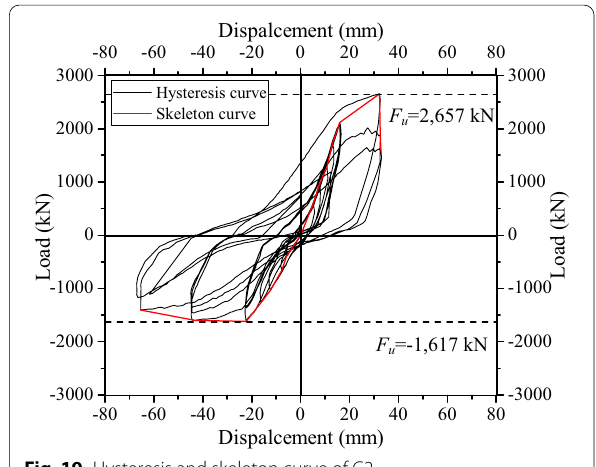
Fig. 19 Hysteresis and skeleton curve of C2.